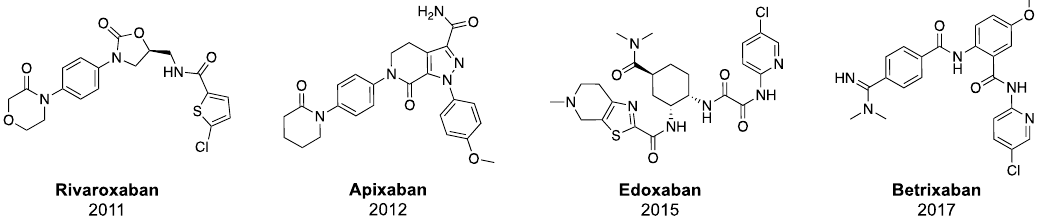
Figure 2. Currently clinically used FXa Inhibitors and the Food and Drug Administration (FDA) year of approval.